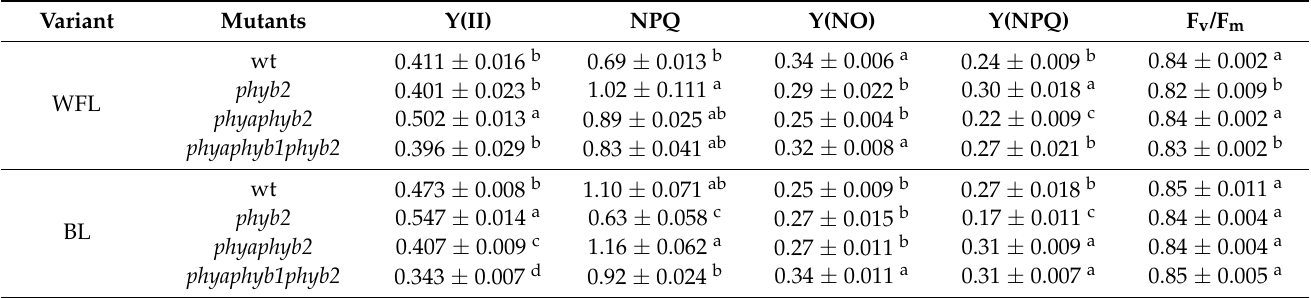
Table 2. Influence of WFL, BL and RL on the main indicators fluorescence chlorophyll Y(II)— PSII effective quantum yield; NPQ—nonphotochemical fluorescence; Y(NO)—quantum yield of nonregulated nonphotochemical energy dissipation in PSII; Y(NPQ)—quantum yield of regulated nonphotochemical energy dissipation in PSII; and F v /F m —PSII maximum quantum yield in leaves from tomato mutant plants on the genes of major phytochromes. Different letters indicate significant differences ( p < 0.05) between the experimental